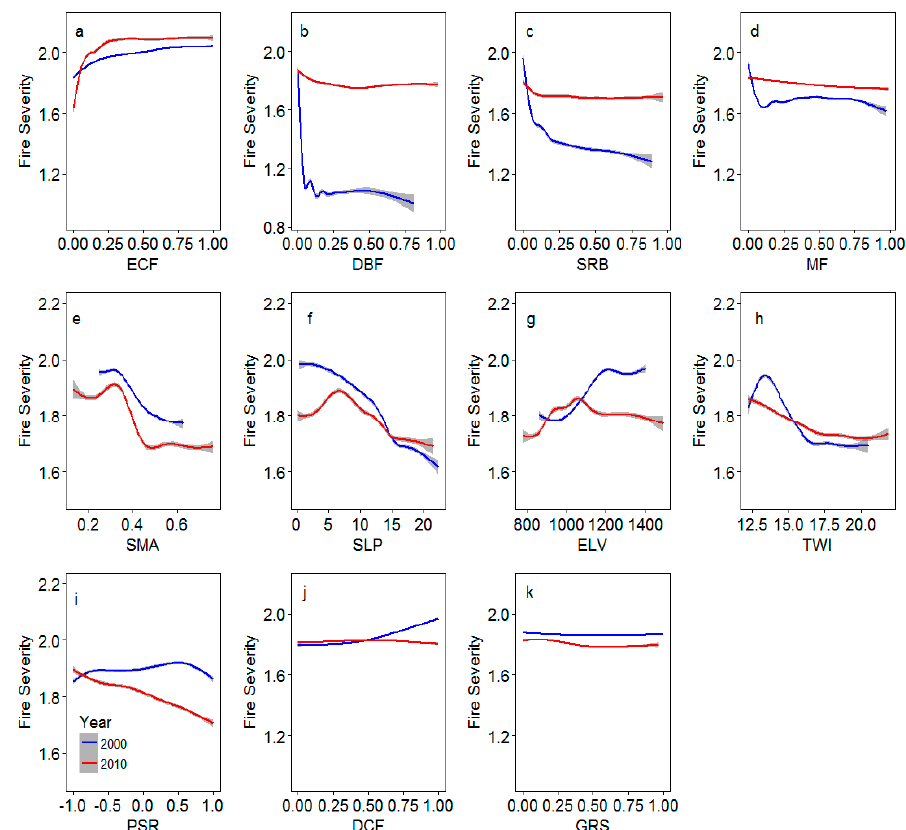
Figure 7. Partial dependence plots of explanatory variables on regulating fire severity in different fire years (2000 in red and 2010 in cyan). This grouping of variables was following the rank as shown in y -axis of Figure 5. The curves demonstrate the smoothed means (solid line) and 95% confidence intervals (gray zone) of an ensemble of 50 models. Variable abbreviations were described in Table 2.